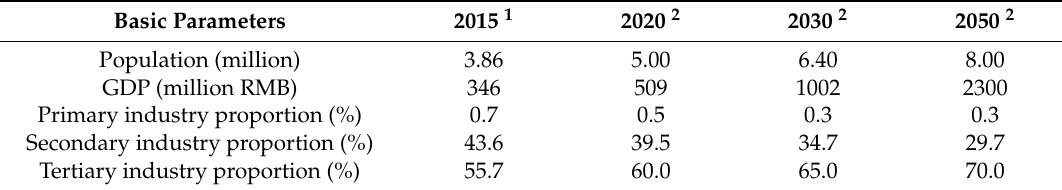
Table 1. Assumptions of key variables for the Xiamen City WEAP